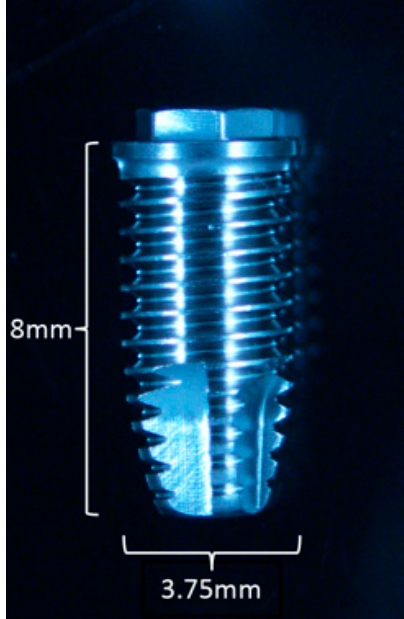
Figure 1. Implant design with 3.75mm width and 8mm length. Representative image of titanium (Ti) implant; copper (Cu) and polyetheretherketone (PEEK) implants with the same design.